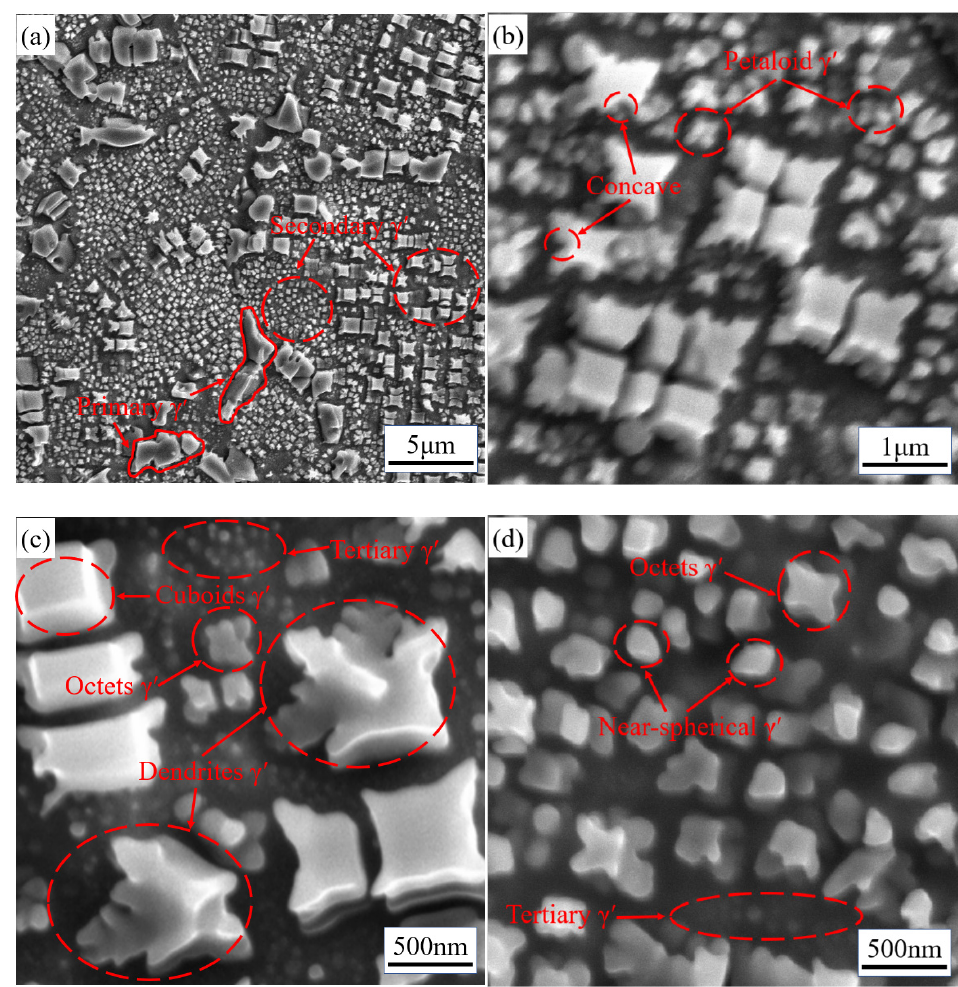
Figure 4. Morphology of γ′ precipitates after holding at 1080 °C for 10 h by FC: ( a ) low magnification, ( b – d ) high magnification and feature distribution of secondary γ′ precipitates and tertiary γ′ precipitates.